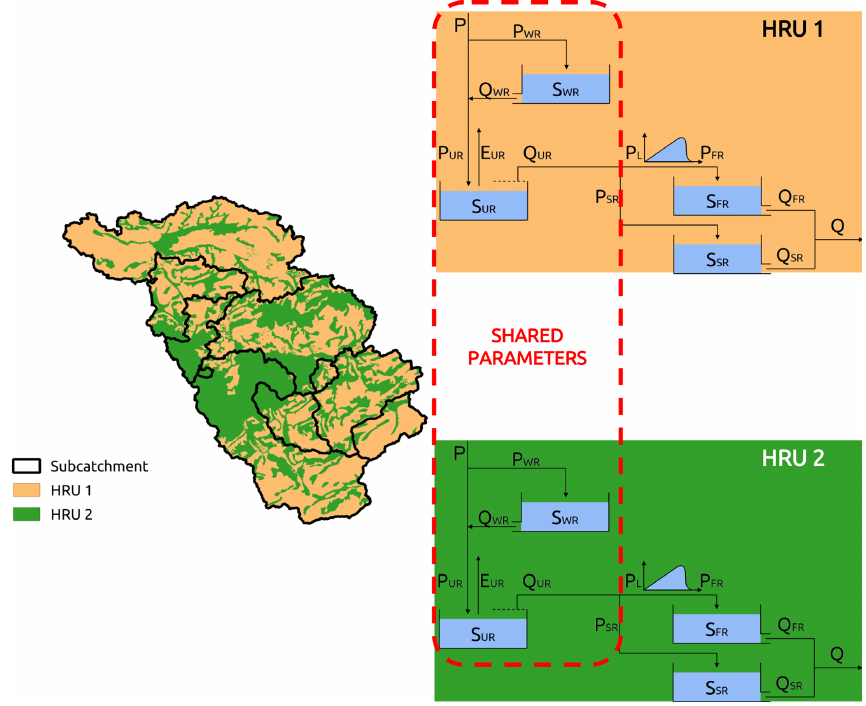
Figure 6. Spatial organization of the model structure: the catchment is divided into subcatchments (black lines), based on the location of the gauging stations, and HRUs (background colour), based on the catchment characteristics. All the HRUs have the same structure, but each HRU has its own parameterization except for some shared parameters. In the case of a single-HRU model (i.e. M0 and M1), the model maintains the subdivision into subcatchments but loses the subdivision into multiple